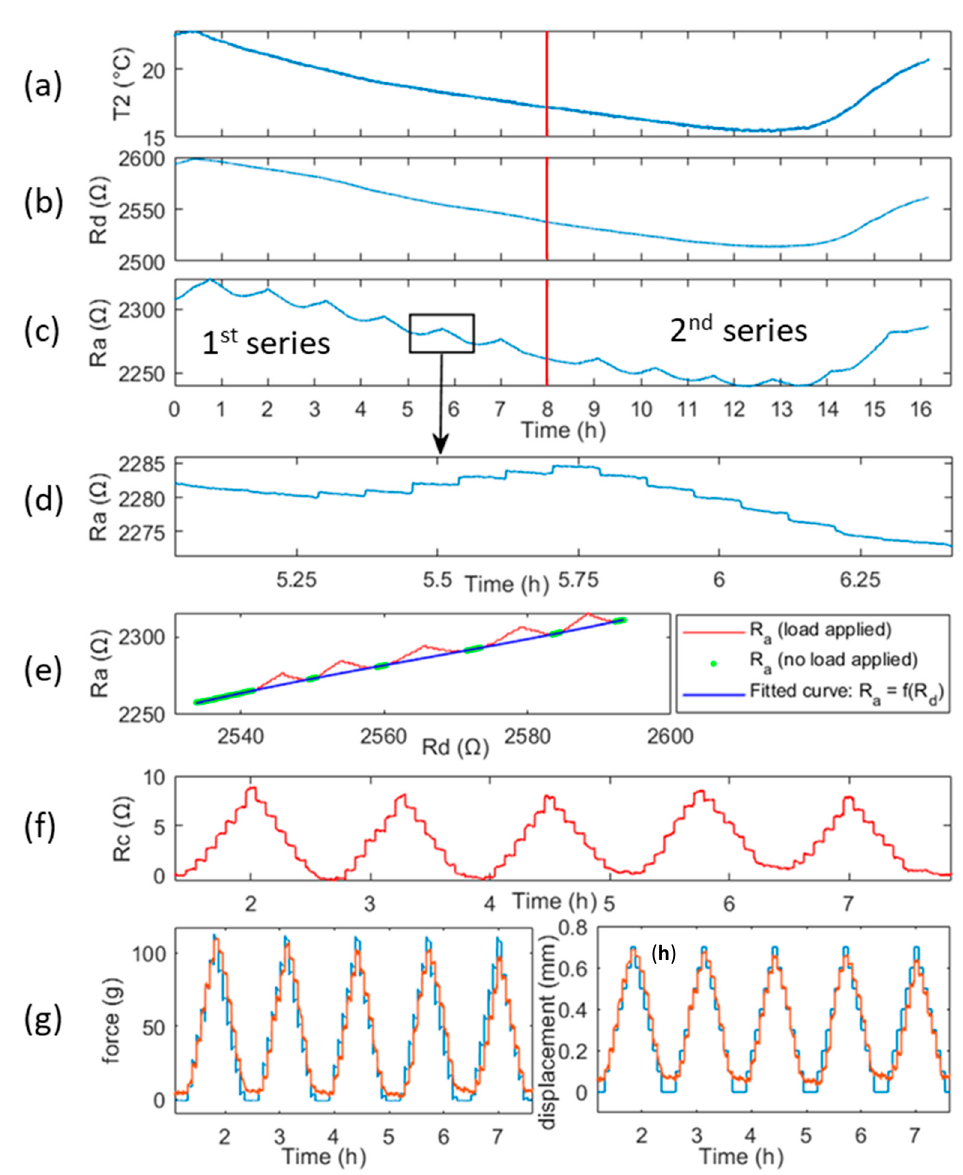
Figure 5. From top to bottom: ( a – d ) T 2 , R d , R a , and R a detail vs. time; ( e ) R a vs. R d , and performed fitting R a = f ( R d ) ; ( f ) R c vs. time (2nd to 6th cycle); force ( g ) and displacement ( h ) vs. time, after temperature compensation (true and estimated values are in blue and red, respectively). All data are referred to as test D2. Temperature compensation and force or displacement reconstruction are done with respect to the 1st series of cycles.